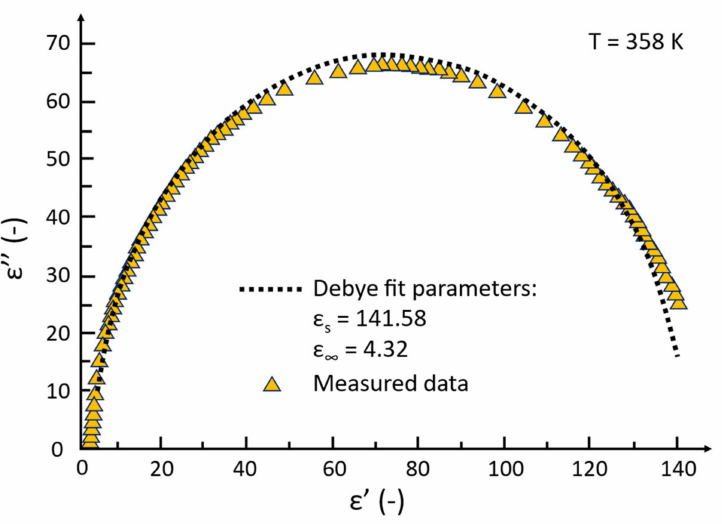
Figure 1. Dielectric behavior of weakly polar ferrofluid based on mineral oil Mogul TRAFO CZ-A in the complex plane. Adapted from